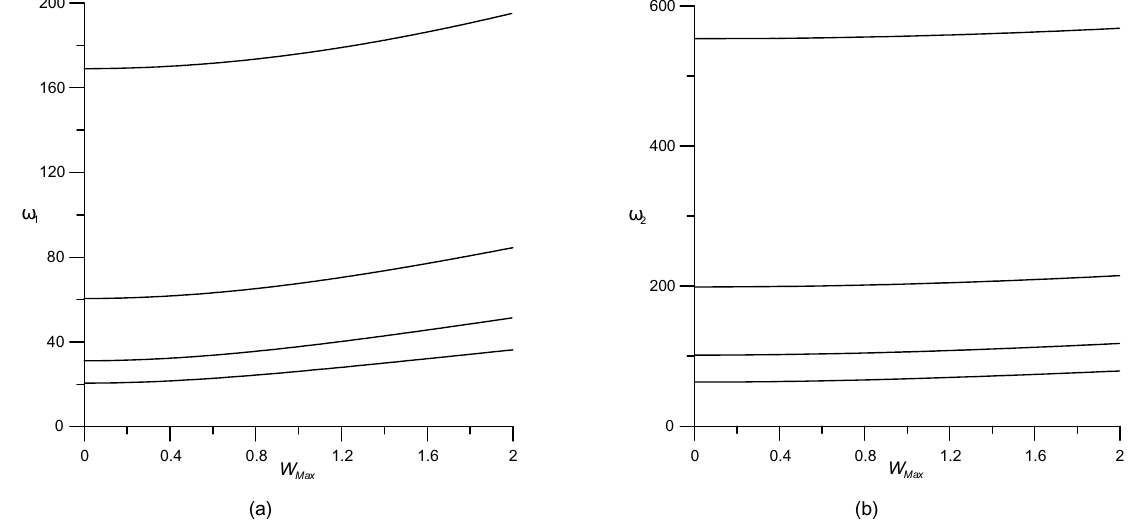
Fig. 13. The first (a) and second (b) natural frequencies of the plate as functions of the maximum nondimensional deflection W Max for hinged-clamped plates of inner radii b = 0 . 1 , 0 . 3 , 0 . 5 , and 0 . 7